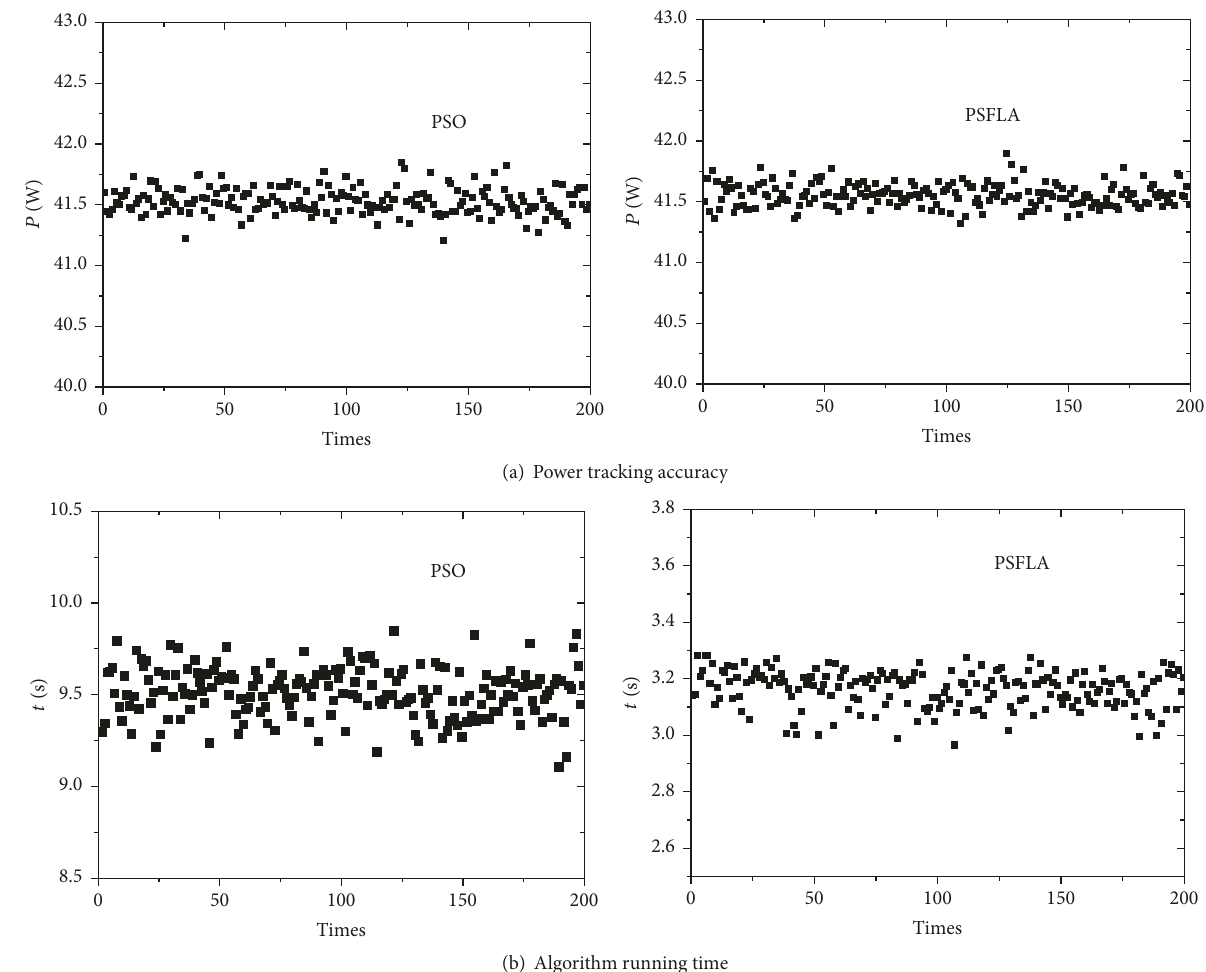
(b) Algorithm running time Figure 17: Experimental results for test 2.